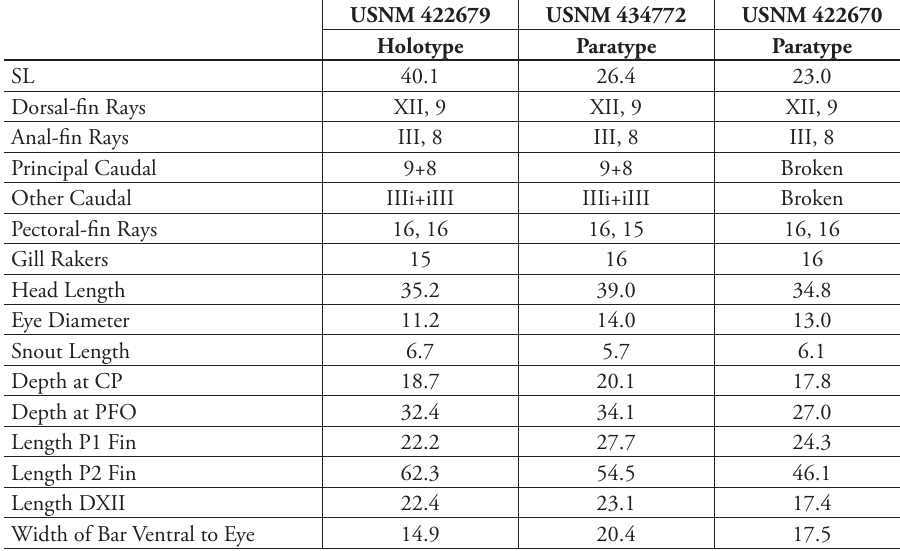
Table 4. Counts and measurements of type specimens of Lipogramma haberi sp. n. Measurements are in percent SL except width of bar ventral to eye, which is in percent head length. CP = caudal peduncle; PFO = pelvic-fin origin; P1 = pectoral fin; P2 = pelvic fin; DXII = twelfth dorsal-fin spine. “Other Caudal” rays include “i” – a slender, flexible, non-spinous, and typically non-segmented ray and “I” – a spinous procurrent